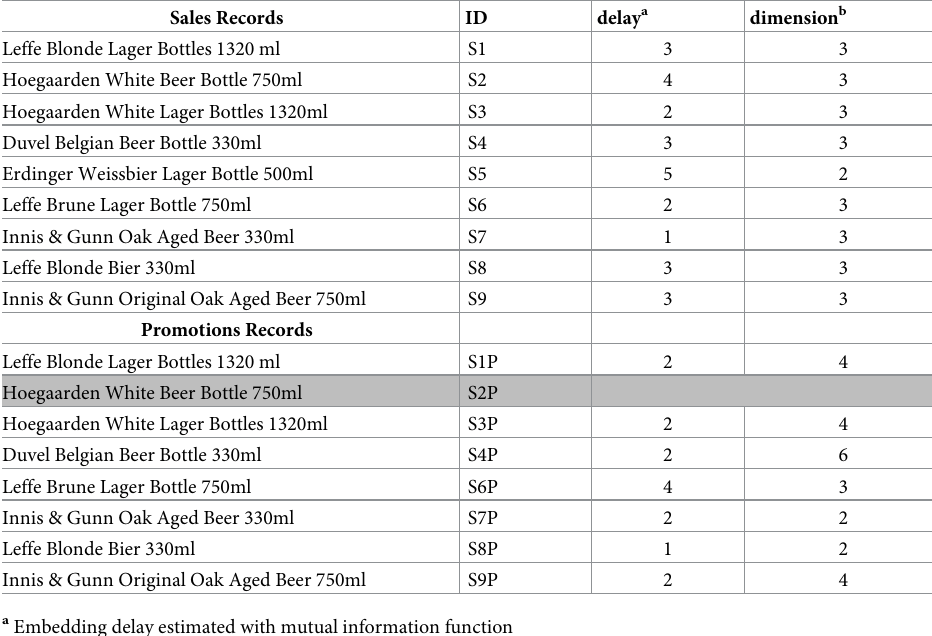
screened for stationarity and nonlinear deterministic dynamic behavior. Arrows between nodes indicate that the signals interact in the same reconstructed real-world market system, and the direction of interaction. The strength of the interaction is given by the fractions near each arrow head, which are the convergent correlation coefficients for each cross mapping (Fig 11, black curves). For example, the convergent correlation coefficient is 0.81 for the cross mapping S3 xmap S3P, which indicates that S3P drives S3. We include interactions in the dia- gram associated with CCM curves exhibiting convergent correlations exceeding 0.33 (the strength of interactions increases as convergent correlations approach 1), and resting at or above 95% confidence levels (Fig 11, red curves). In addition, we include interactions whose cross mappings pass delayed (extended) CCM tests to rule out non-causal synchronous behav- ior, as demonstrated by delayed CCM curves with peaks at nonpositive delays (Fig 12). The community interaction diagram (Fig 10) begins to shed valuable light on empirical questions raised in the literature outlined above: Do a brand’s promotions substantially increase sales? Do brands use promotions to cannibalize the sales shares of competing brands? Given the nature of the Tesco dataset, we additionally consider whether this behavior changes between brands owned by different multinational breweries. A prerequisite for responding to these questions is that the underlying interactions are detected in the first place, and the com- munity interaction diagram provides empirical evidence of this. We focus on the area of the diagram (shaded red) containing bilateral interactions between the 1 st (Leffe Blonde Lager Bot- tles 4X330 1320ml) and 3 rd (Hoegaarden White Lager Bottles 4X330 1320ml) leading brand configurations in category sales shares. Both brands are owned by ABInbev. The red-shaded area also includes interactions between these ABInbev brands and the 9 th largest sales-share brand (Innis & Gunn Original Oak Aged Beer 750ml), which is not owned by ABInbev.